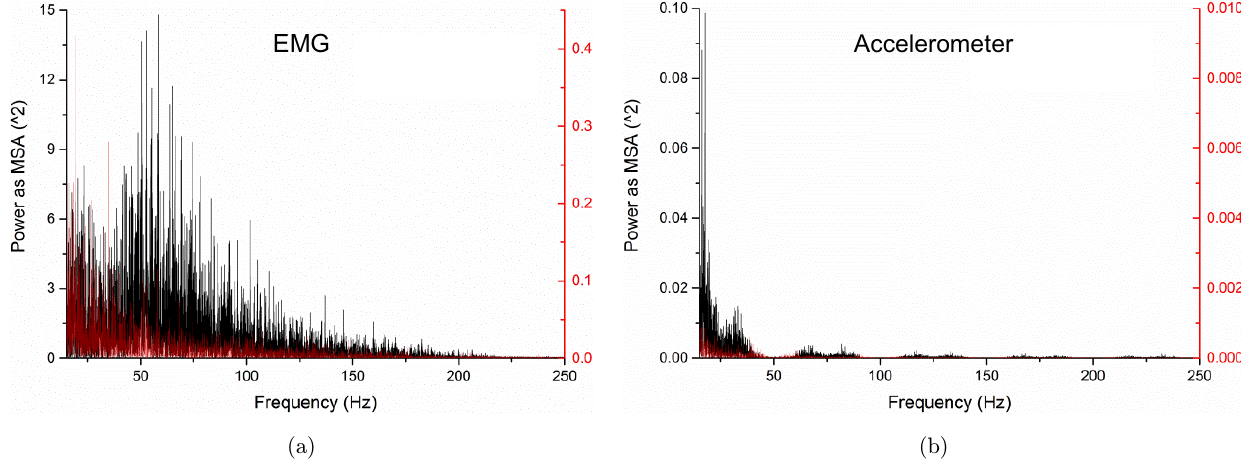
Fig. 9. Power spectra of EMG (a) and ACM (b) during rest (red) versus dynamic contraction (black). During dynamics contraction, the power spectra of ACM similarly appears in the frequency range up to 40 Hz. However, in EMG it widens up to 200 Hz.